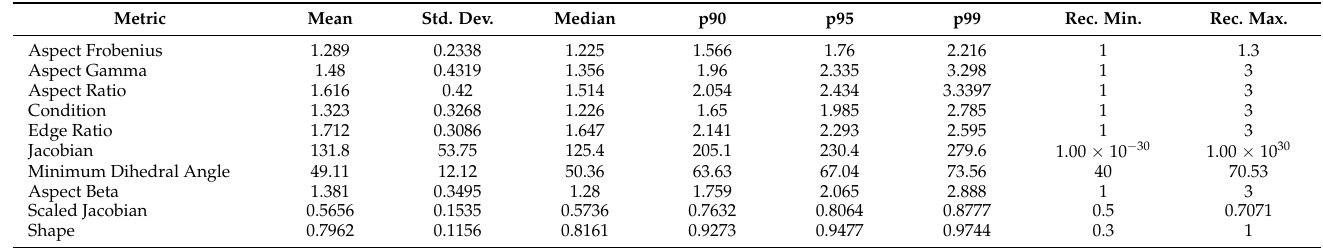
Table A1. Mesh quality metrics of the pelvis mesh shown in Figure 3D obtained using the Verdict library. The first three columns correspond to the mean, standard deviation and median of each metric over the whole mesh. The next three columns are the 90%, 95% and 99% percentiles of each metric, respectively. Finally, the last two columns show the minimum and maximum limits of the recommended intervals for each